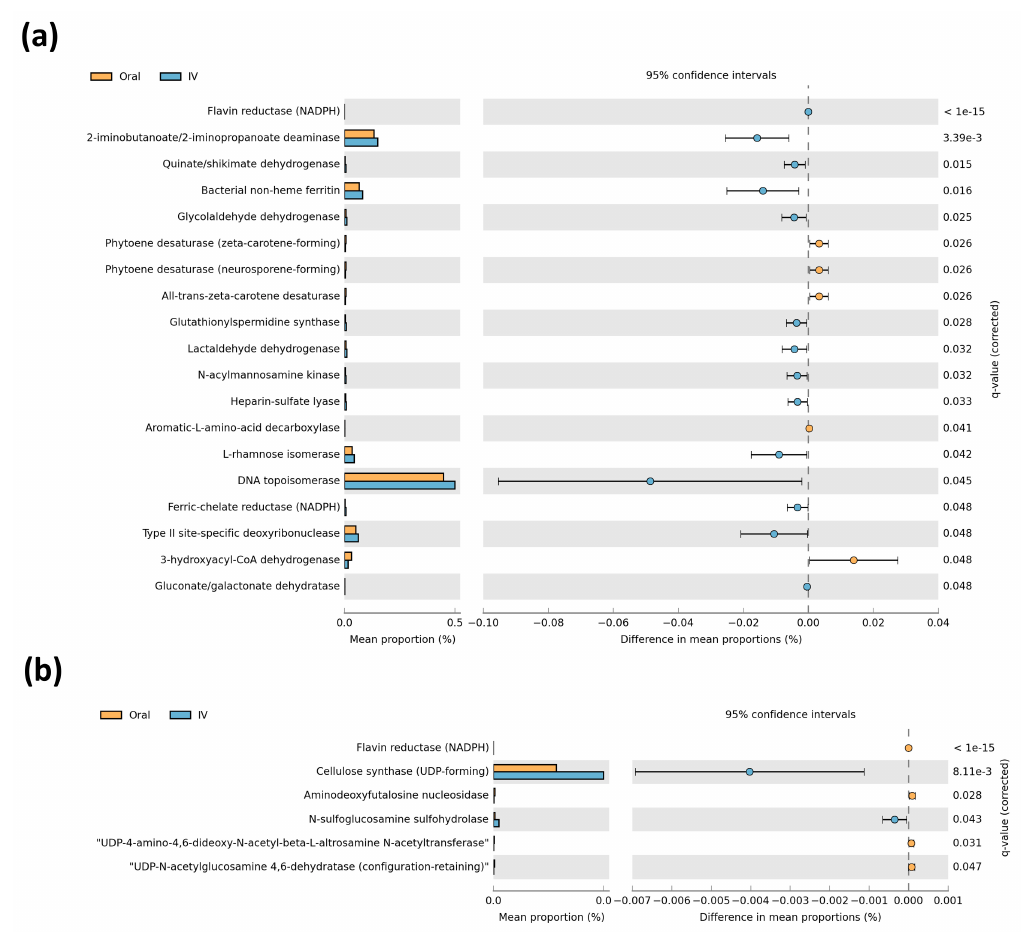
Figure 4. Comparison of predictive metagenomics between iron treatment groups. Predictive metagenomic analysis of enzyme classification abundances between oral and intravenous (IV) iron treatments, based on off-tumor ( a ) and on-tumour ( b ) microbial populations. Corrected q-values were calculated following multiple testing correction using Storey false discovery rate. q-values ≤ 0.05 were considered statistically